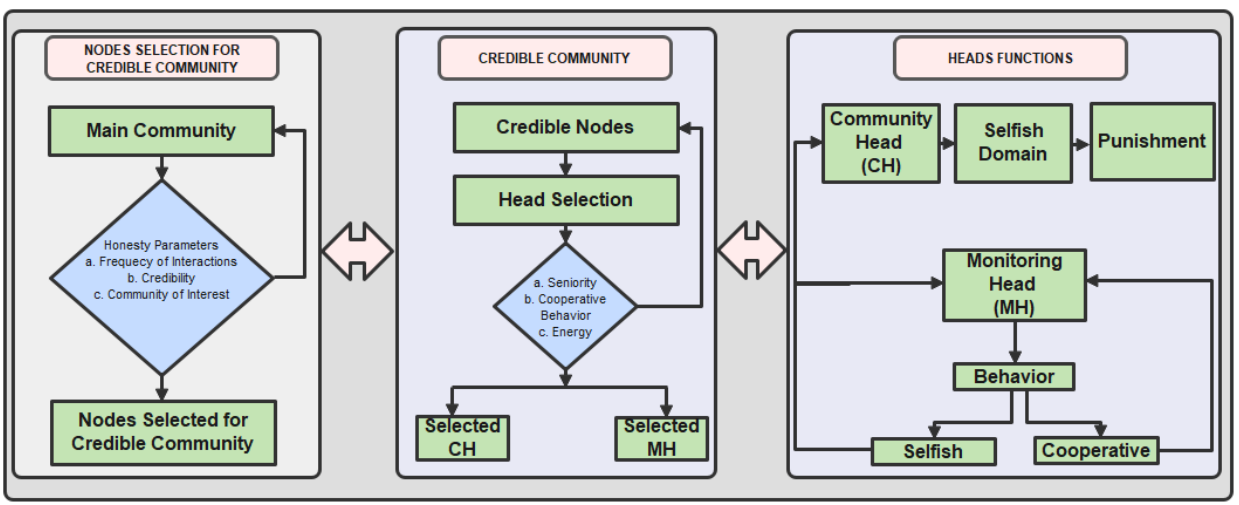
Figure 1. System